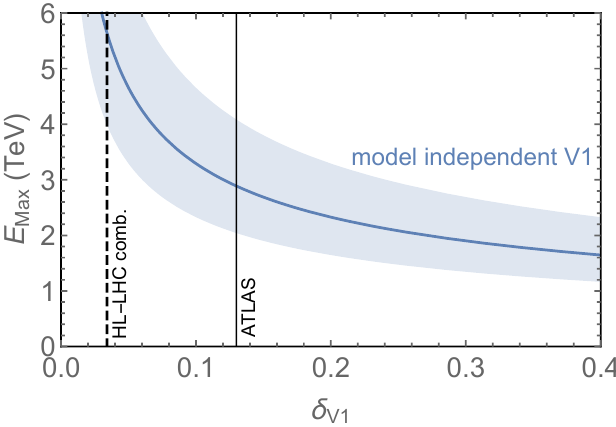
Figure 5 . The unitarity bound as a function of the deviation in the hV V coupling. The optimal bound lies between the model-independent and SMEFT estimate from the dimension-6 operator eq. (3.10) and thus they are the same. The band around the model-independent scale results from ˆ varying the unitarity bound to 1 ≤ | M| ≤ 2 . For comparison, we show the 95% C.L. limits on δ V 1 2 from ATLAS [30] and a projected HL-LHC combination